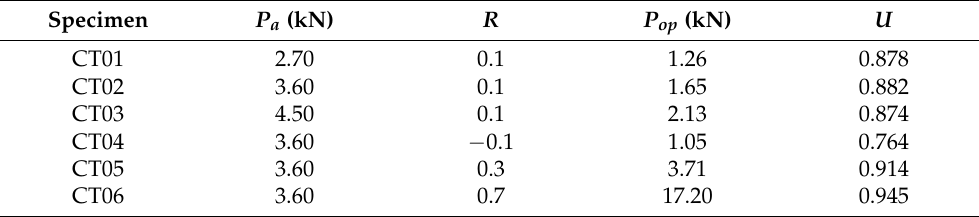
Table 3. The crack opening force and crack closure coefficient under different loading conditions.